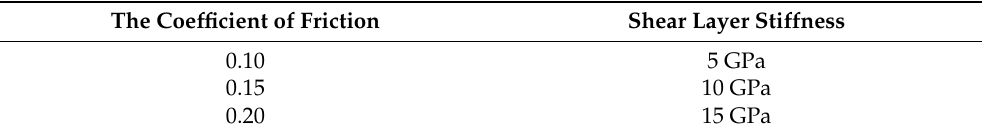
Table 2. Interface parameters.